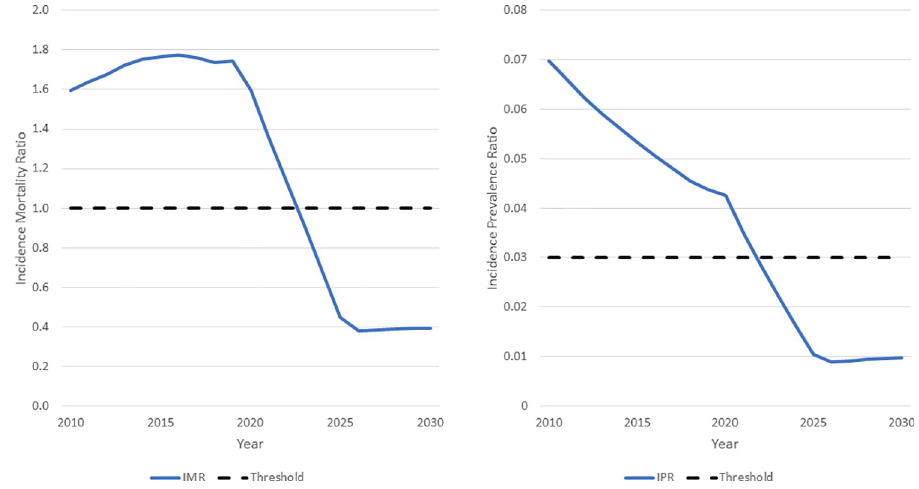
Fig 3. Indicators of transition control. I AU : AbbreviationlistshavebeencompiledforthoseusedthroughoutFigs 3 and 6 : Pleaseverifythatallentriesarecorrect : MR, incidence mortality ratio; IPR, incidence prevalence ratio. https://doi.org/10.1371/journal.pmed.1003831.g003 key population prevention services (prevention services for key populations), biomedical pre- vention (VMMC and PrEP for adolescents and adults), and treatment (ART). Across all coun- tries, treatment scale-up accounts for two-thirds of infections averted, key population services 17%, behavior change 14%, and biomedical 2%. This pattern varies by region as shown in Fig 4. Achieving these targets implies that the number of people on ART would increase from 26 million in mid-2020 to 35 million by 2025 before declining slowly to 34 million by 2030. Modeling of the COVID-19 scenarios indicates that the disruptions could lead to 10% more new infections in 2021 and 9% additional AIDS deaths, but, by 2025, the effect of the disrup- tion would no longer be evident (S1 Fig).